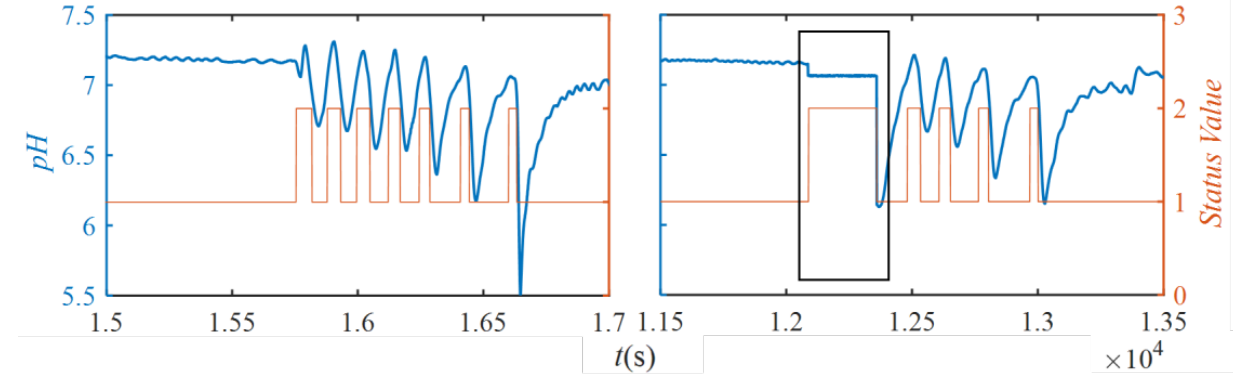
Figure 8. Sophisticated attack in dataset 6 (left: normal operation and right: attack period in boxed portion). Blue line = value of AIT202 and orange line = status value of P203.